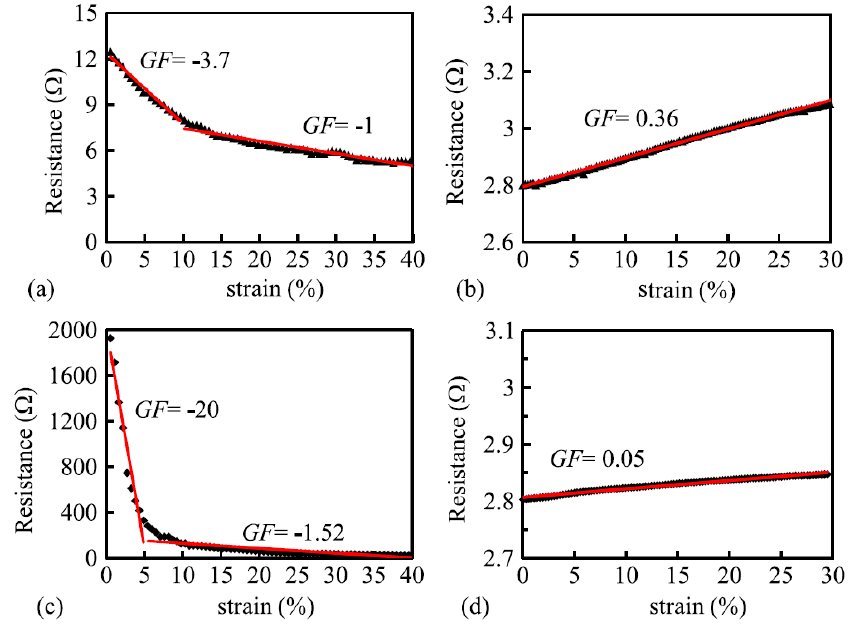
Figure 14. Course-wise response of ( a ) Cotton-steel knitted sensor and ( b ) nylon plated material; Wale-wise (transverse) responses of ( c ) cotton-steel and ( d ) nylon plated material [65].